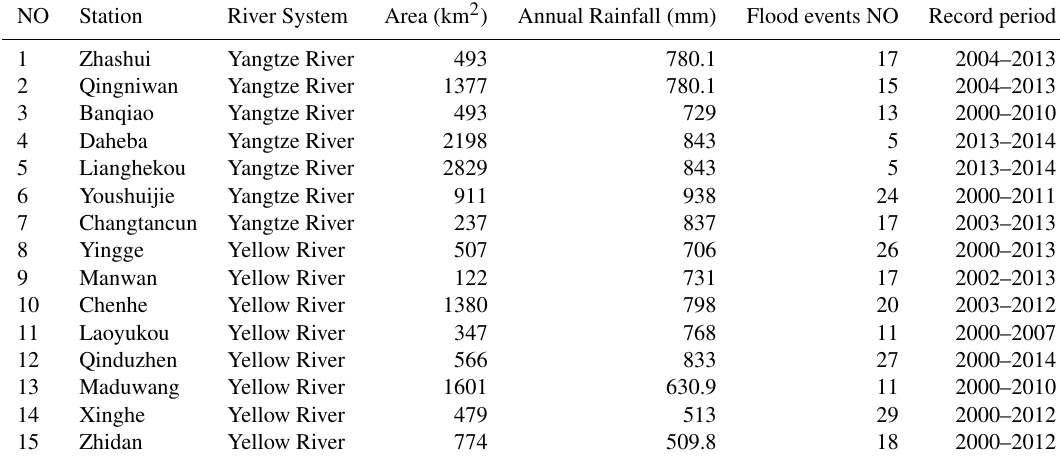
Table 1. Information and characteristics of the study